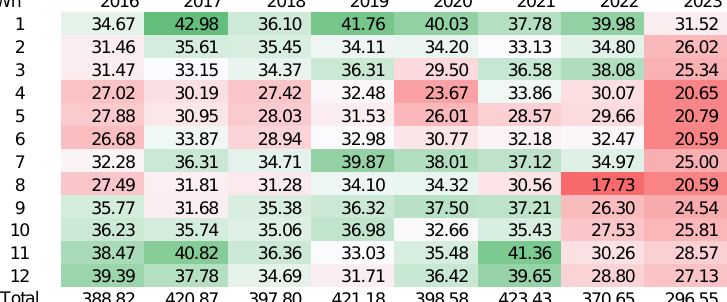
Figure 6. Neutral forecast of natural gas supply to Italian end users for 2024. Forecast exercised for the period September 2022 to December 2023. These data can be found here: https://www.ec.europa.eu/ (accessed on 20 March 2022).